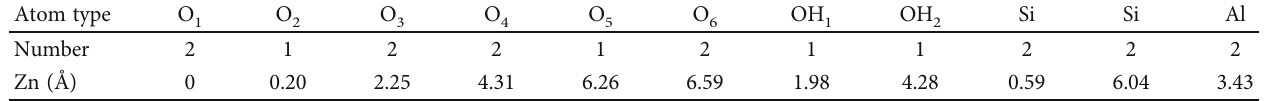
Table 2: The z atomic coordinates within the 2 :1 layer framework along the c ∗ axis